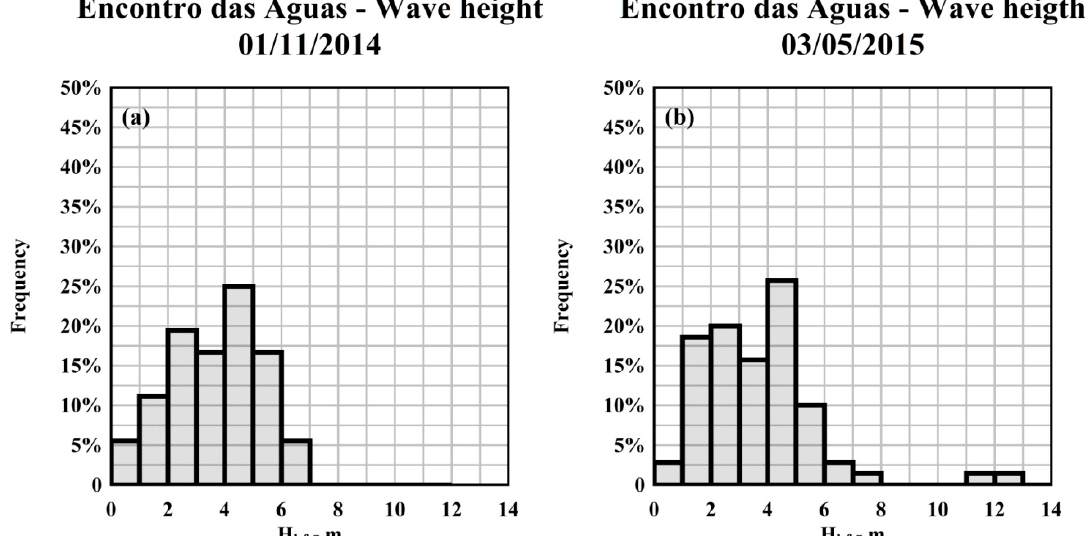
Figure 10. Frequency distribution of bedform wave height H bf for (a) FS − CNS1 and (b) FS − CNS2.